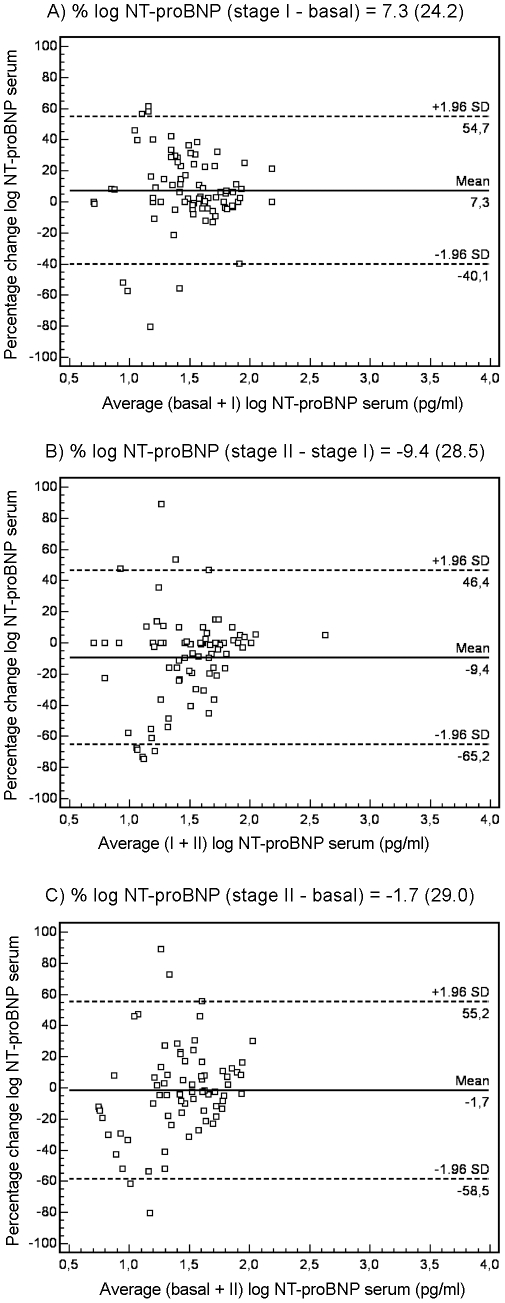
Bland-Altman plots for changes in NT-proBNP serum levels in hypertensive patients without hypertrophy.Bland-Altman plot showing agreement between the logarithm of NT-proBNP levels percentage change against the average of the logarithm of NT-proBNP levels in basal + stage I (A), stage I + stage II (B) and basal + stage II (C). The solid line represents the mean of the percentage change. The dashed lines define the limits of agreement (standard deviation of percentage of change ×1.96 SD). NT-proBNP, N-terminal pro-brain natriuretic peptide levels; SD, standard deviation; stage I, 12-month follow-up; stage II, 24-month follow-up.